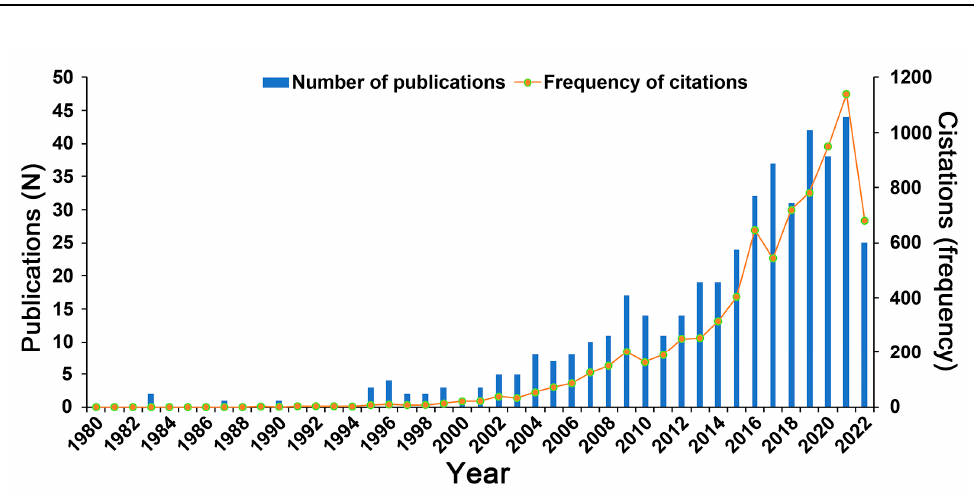
Figure 2. Number and citation frequency of publications in Cistanche- related study